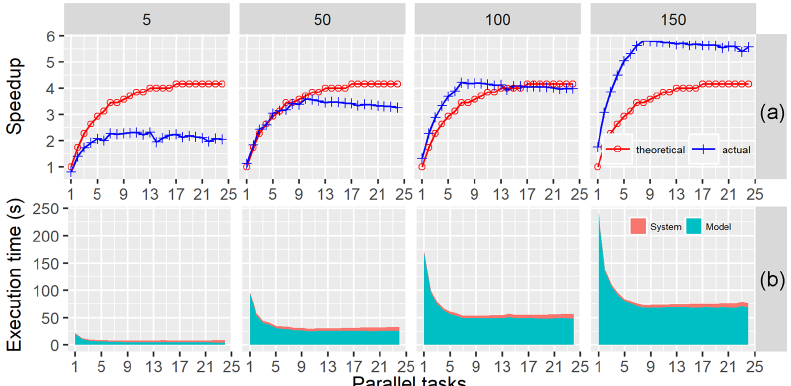
Figure 6. Speedups (a) and job execution times (b) for single model simulation on a Windows server versus the number of parallel tasks for the four synthetic hydrological